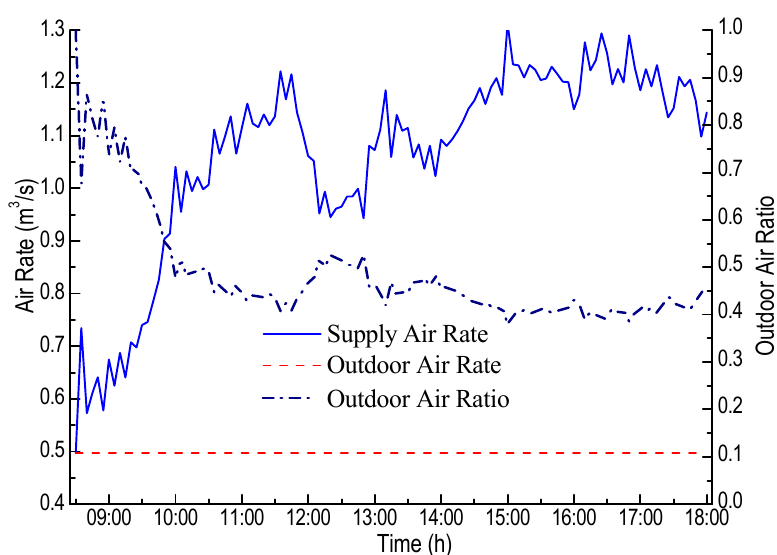
Figure 9. Supply air rate of six zones under Scenario 2.